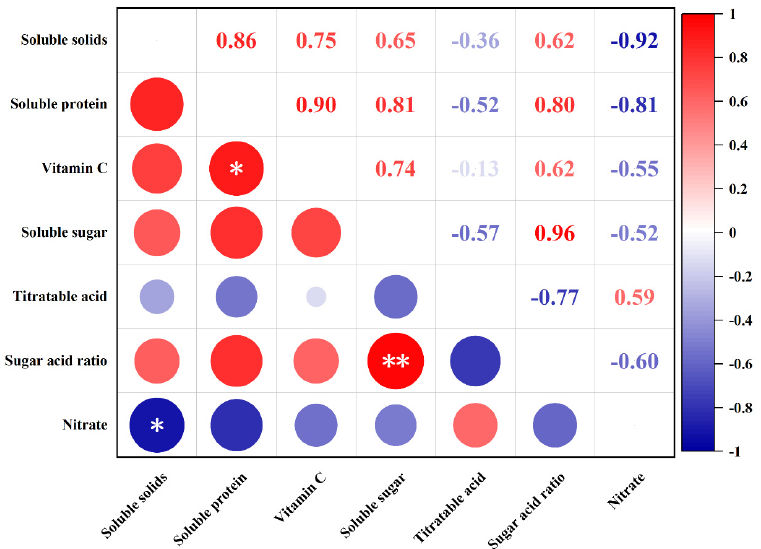
Figure 5. Pearson correlation analysis of nutritional quality under different levels of water deficit.